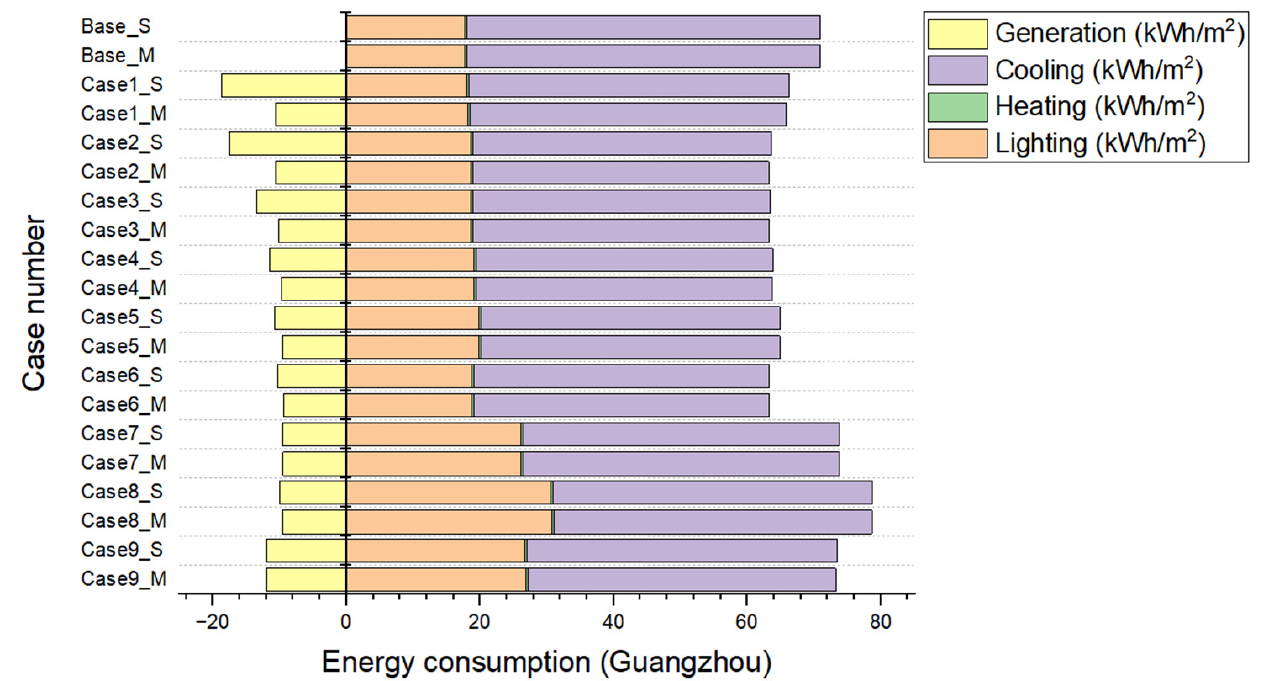
Figure 12. Energy consumption of single-story and multi-story buildings (in Guangzhou) with different PVSDs.